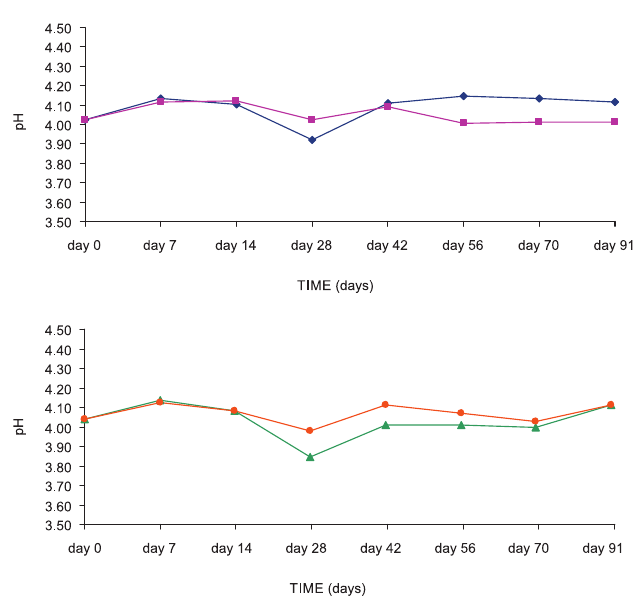
FIGURE 2 - The pH variation of sildenafil citrate aqueous solutions (mean ± standard deviation; n = 3).  preservative-free solution stored at 5 ºC ± 3 ºC and  stored at 25 ºC ± 2 ºC/60% RH ± 5% RH  solution containing preservative stored at 5 ºC ± 3 ºC and  stored at 25 ºC ± 2 ºC/60% RH ± 5%